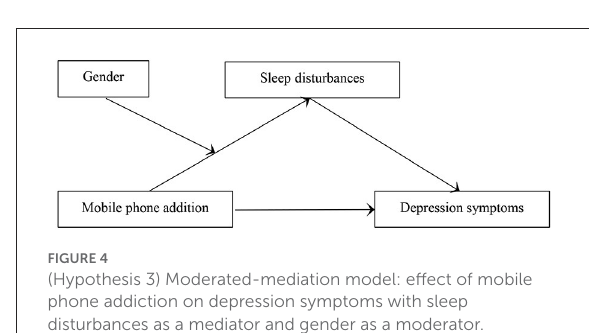
FIGURE4 (Hypothesis 3) Moderated-mediation model: effect of mobile phone addiction on depression symptoms with sleep disturbances as a mediator and gender as a